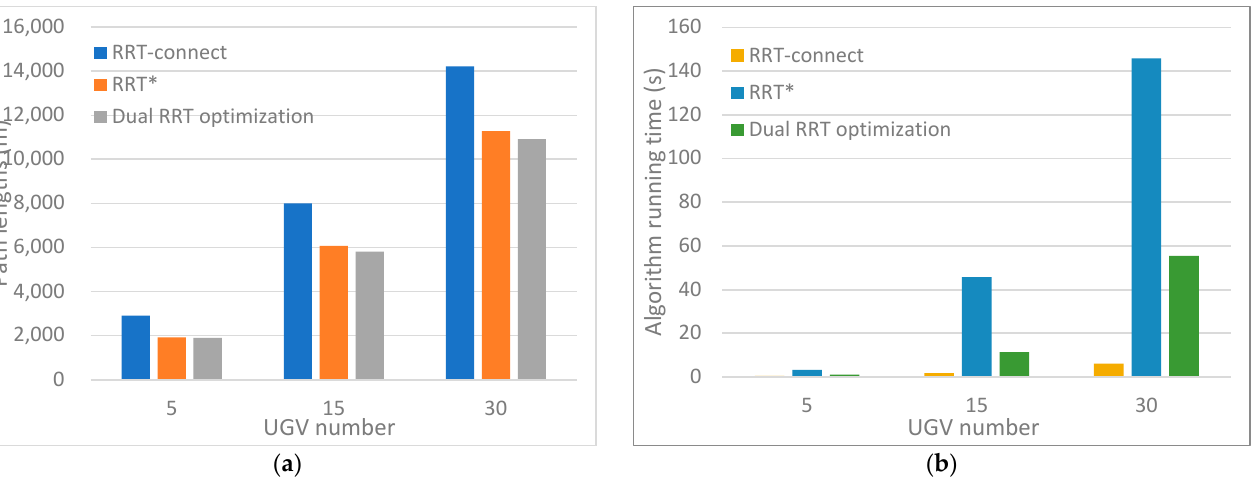
Figure 12. Total path result length and running time for each algorithm. ( a ) is the total length of the path result for each algorithm with different numbers of vehicles; ( b ) is the running time of each algorithm for different numbers of vehicles.